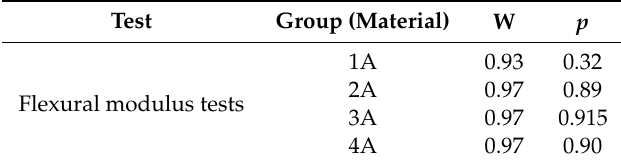
Table 4. Shapiro-Wilk test of the W and p values of the flexural modulus test results.